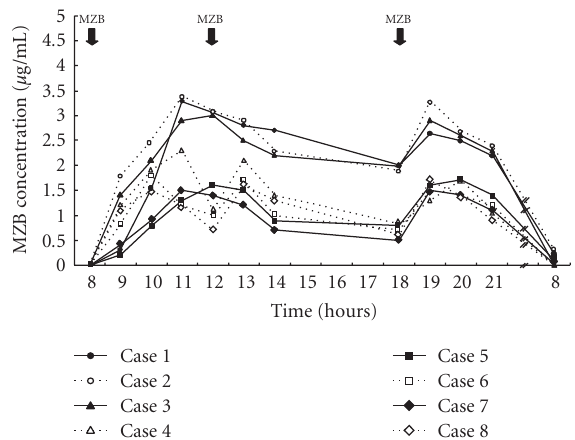
Figure 1: Change in the serum MZB concentration of each patient on the days when MZB was